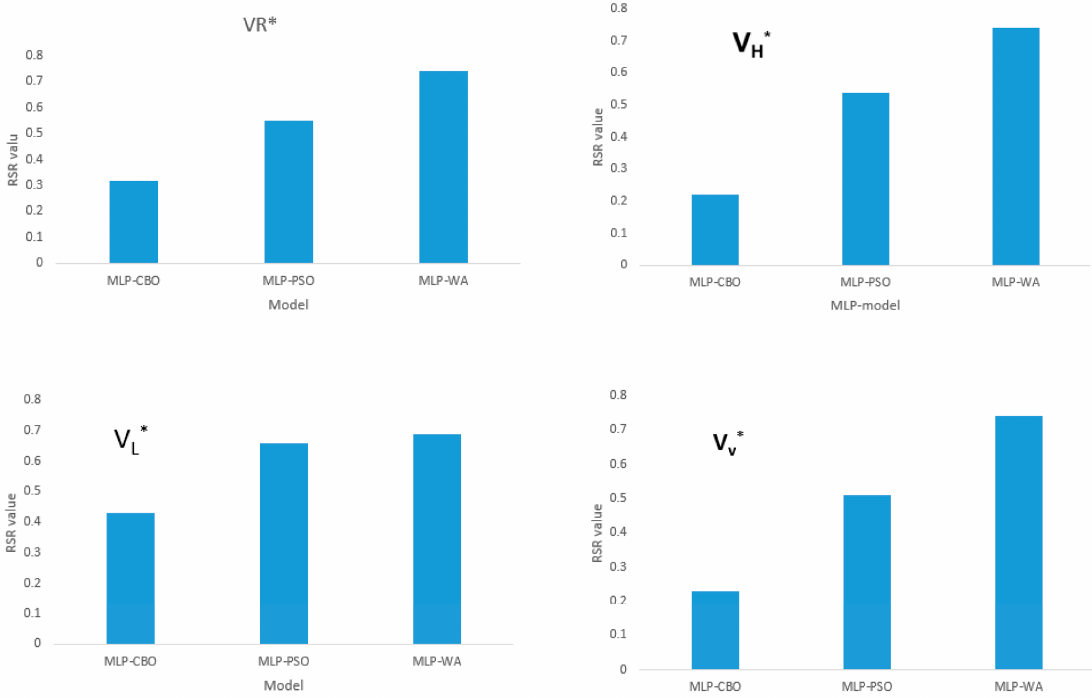
Figure 12. The computed RSR for di ff erent